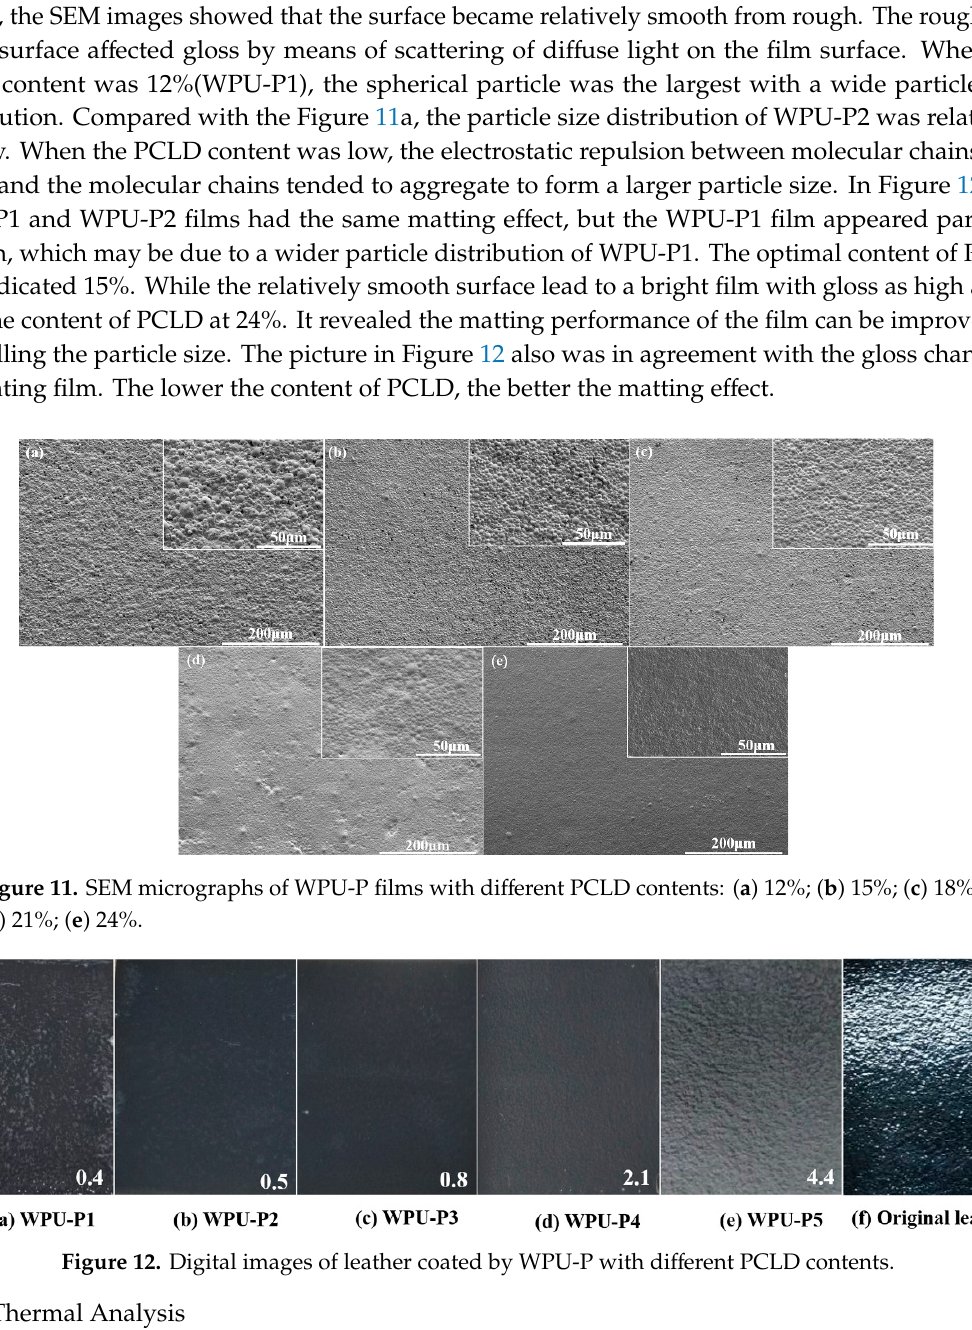
Figure 10. The particle sizes of WPU-P dispersions and gloss of WPU-P films with different PCLD